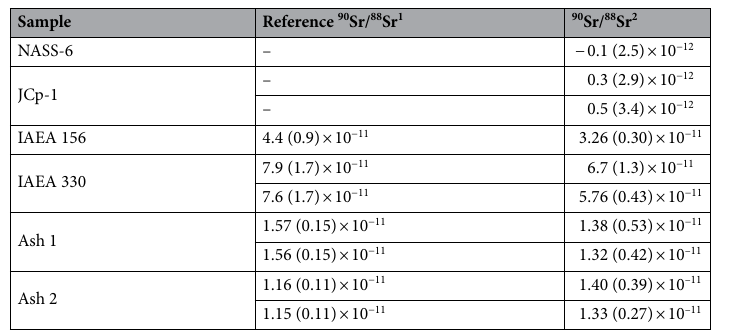
Table 3. Results of 90 Sr/ 88 Sr measurements of the environmental and biological samples. 1 Decay corrected to the reference date (see Table S2 in supporting information). 2 Noise corrected values using the average 90 Sr count rate of NIST SRM 987 measurements (see text for details). All the errors in the parenthesis are 2 SD.